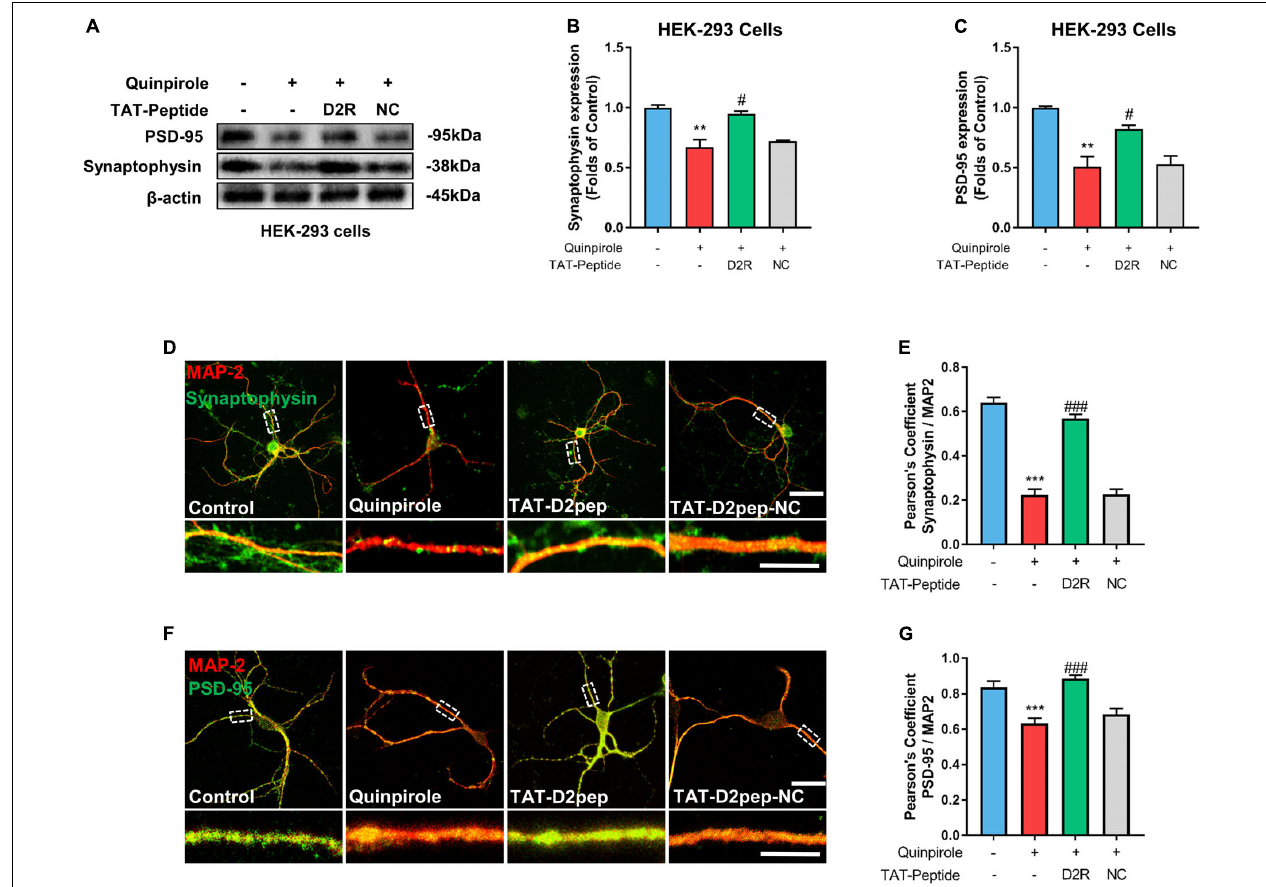
FIGURE 4 | TAT-D2pep blocks D2R hyperactivity-induced down-regulation of synaptophysin and PSD-95. (A–C) Western blot analysis showed that TAT-D2pep but not TAT-D2pep-NC increased expression of synaptophysin and PSD-95 in HEK-293 cells co-expressing D2R-EGFP and DISC1 mCherry; n > 3 per group. (D,E) Representative images of striatal neurons co-immunostained with MAP-2 and synaptophysin. Pearson’s correlation coefficients values for MAP-2 and synaptophysin colocalization assays. (F,G) Representative images of striatal neurons co-immunostained with MAP-2 and PSD-95. Pearson’s correlation coefficients values for MAP-2 and PSD-95 colocalization assays. Scale bars = 50 µ m and 15 µ m (enlarged), ** P < 0.01 and *** P < 0.001 versus control, # P < 0.05 and ### P < 0.001 versus quinpirole by one-way analysis of variance (ANOVA) with post hoc Tukey